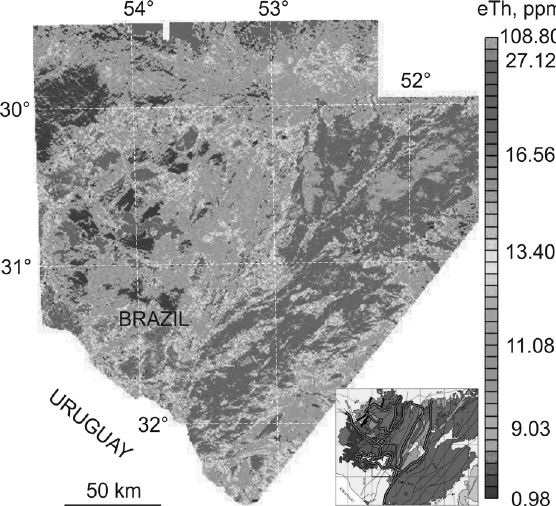
Figure 9 - Map of eTh signal over the Sul-Riograndense Shield. For interpretation of the references to color in this fi gure legend, the reader is referred to the web version of this